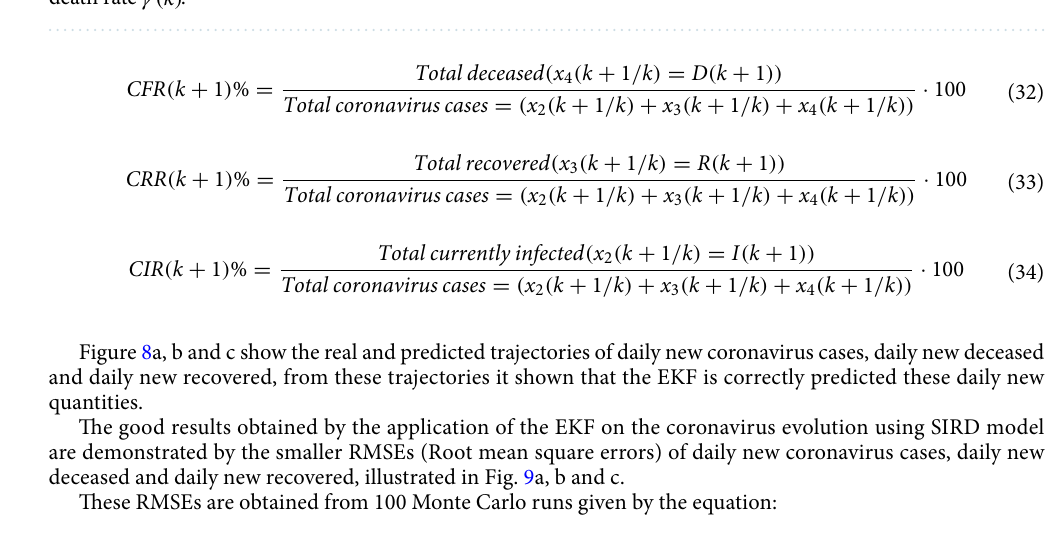
Figure 4. Real and predicted trajectories, ( a ) daily infection rate α( k ) , ( b ) daily recovery rate β( k ) and ( c ) daily death rate γ( k )